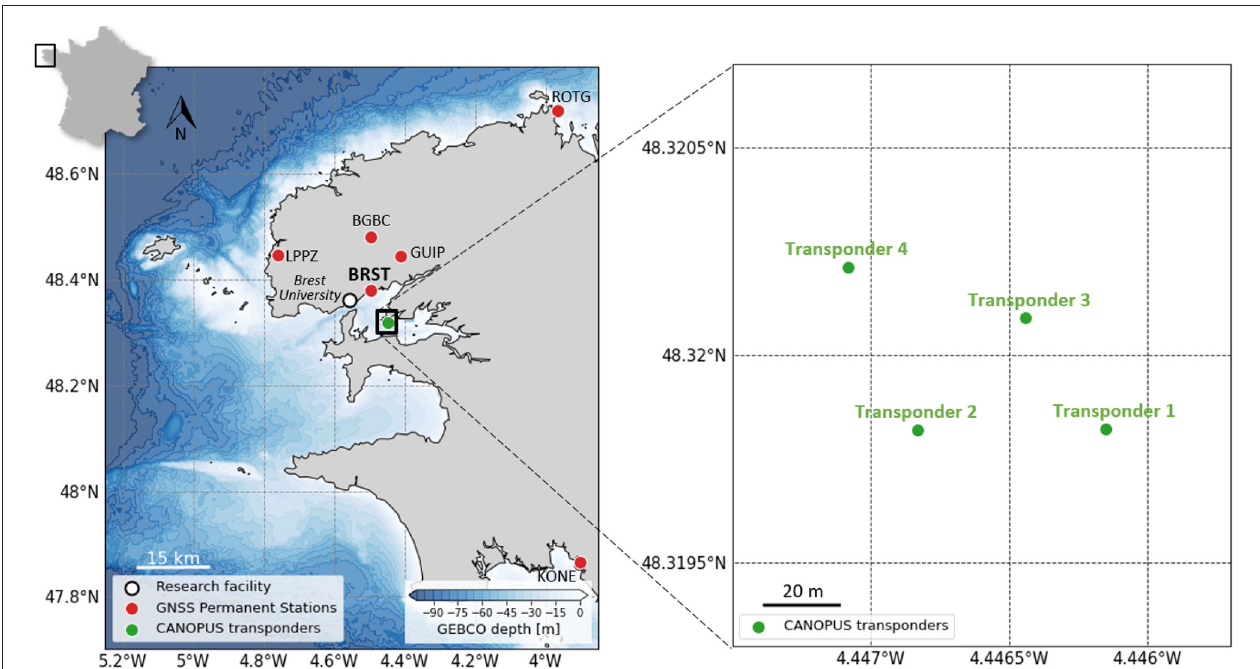
FIGURE 1 | Study area. (Left) The Bay of Brest and the permanent GNSS network (red dots); (Right) Geographic locations of the transponders during the